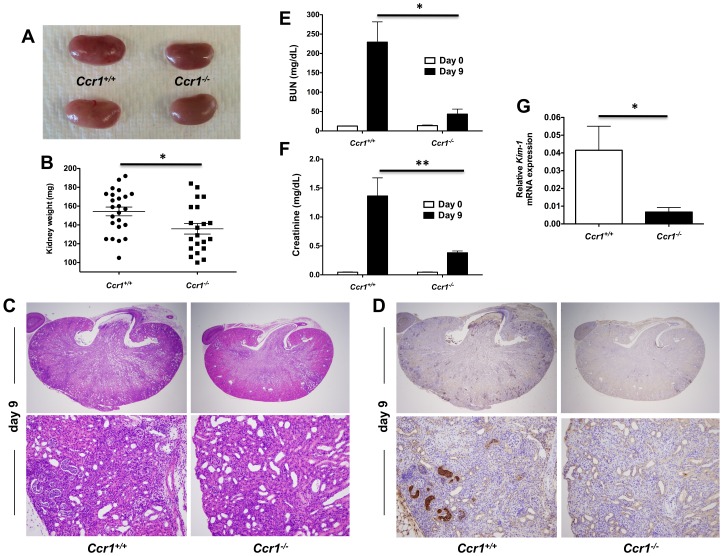
Ccr1 deficiency results in decreased kidney tissue damage.(A) Representative gross pathology pictures of Ccr1+/+ and Ccr1−/− kidneys at day 9 post-infection. Ccr1+/+ kidneys appear more swollen and pale compared to Ccr1−/− kidneys. (B) Weight of Ccr1−/− kidneys is significantly less compared to Ccr1+/+ kidneys at day 9 post-infection. *
P = 0.01. Data are from four independent experiments with twenty-four Ccr1+/+ and twenty-one Ccr1−/− mice. (C) Representative histopathology cross-sections of Ccr1+/+ and Ccr1−/− kidneys at day 9 post-infection. Ccr1+/+ kidneys sustain significantly greater inflammatory changes compared to Ccr1−/− kidneys. Original magnifications: 20× (top row) and 400× (bottom row). Images are representative of eight Ccr1+/+ and eight Ccr1−/− mice from three independent experiments. (D) 7/4 IHC staining of Ccr1+/+ and Ccr1−/− kidneys at day 9 post-infection. Original magnifications: 20× (top row) and 400× (bottom row). Images are representative of six mice from two independent experiments. (E–F) Kidney failure is significantly more severe in Ccr1+/+ compared to Ccr1−/− mice at day 9 post-infection as shown by (E) BUN and (F) creatinine measurements in mouse serum. *
P<0.001. **
P<0.01. Data are from two independent experiments using eight Ccr1+/+ and eight Ccr1−/− mice. (G) Relative mRNA expression of KIM-1 is greater in Ccr1+/+ kidneys compared to Ccr1−/− kidneys at day 9 post-infection. Data are from one experiment with four Ccr1+/+ and four Ccr1−/− mice per time point. *
P = 0.01.